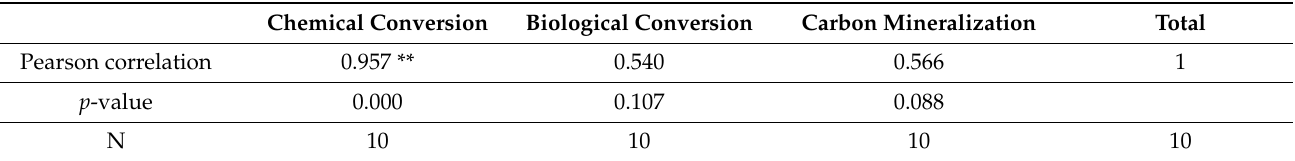
Figure 7. R&D investment in CCU over the past ten years from 2011 to 2020 (data from MSIT, 2021). Correlation analysis between R&D investment in CCU over the past ten years and (i) chemical conversion, (ii) biological conversion, and (iii) carbon mineralization are shown in Table 3 below. Only CO 2 chemical conversion shows a significant correlation to CCU investment with volatility. Table 3. The result of the correlation between R&D investment in CCU.